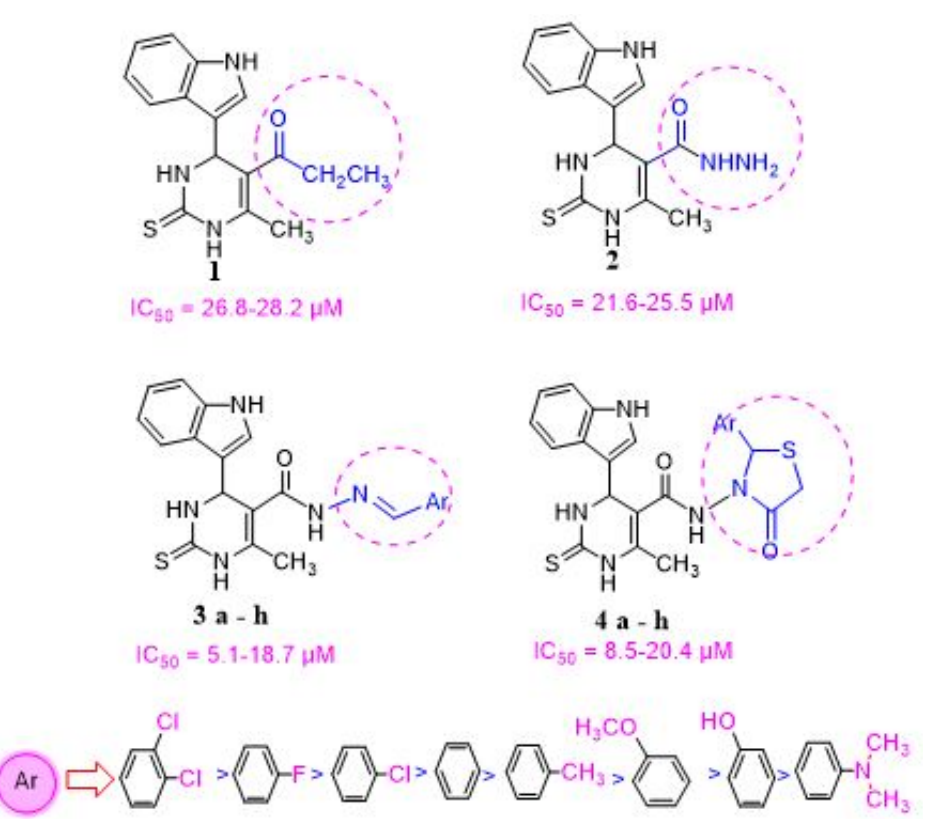
Figure 6. Structure activity relationship (SAR) of the pyrimidine derivatives against different cell lines. Table 2. Effect of treatment by compounds 3g , 4f , 4g , and 4h on MST, % ILS, tumor volume, and viable tumor cell count in EAC tumor bearing